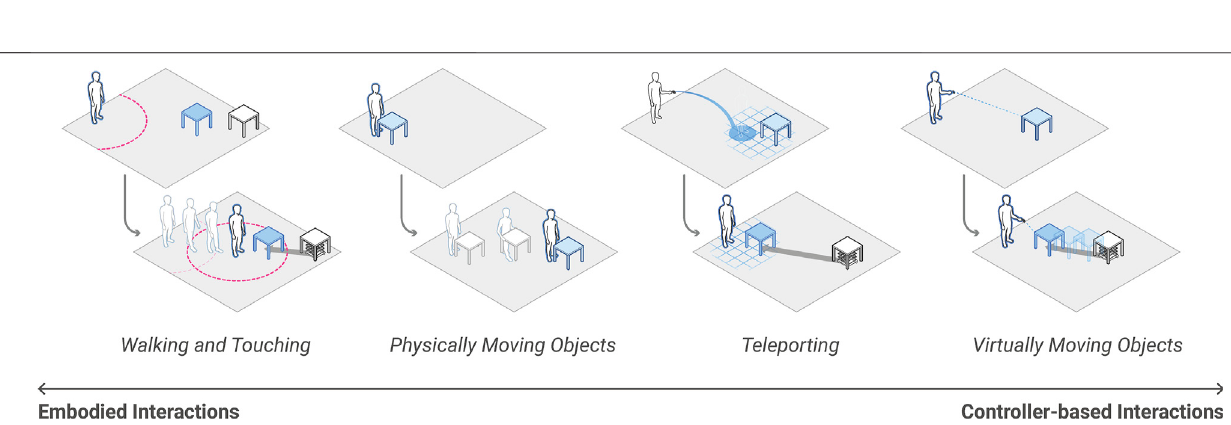
Frontiers in Robotics and AI |